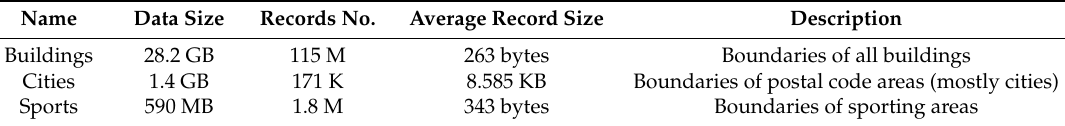
Table 3. Real spatial datasets.